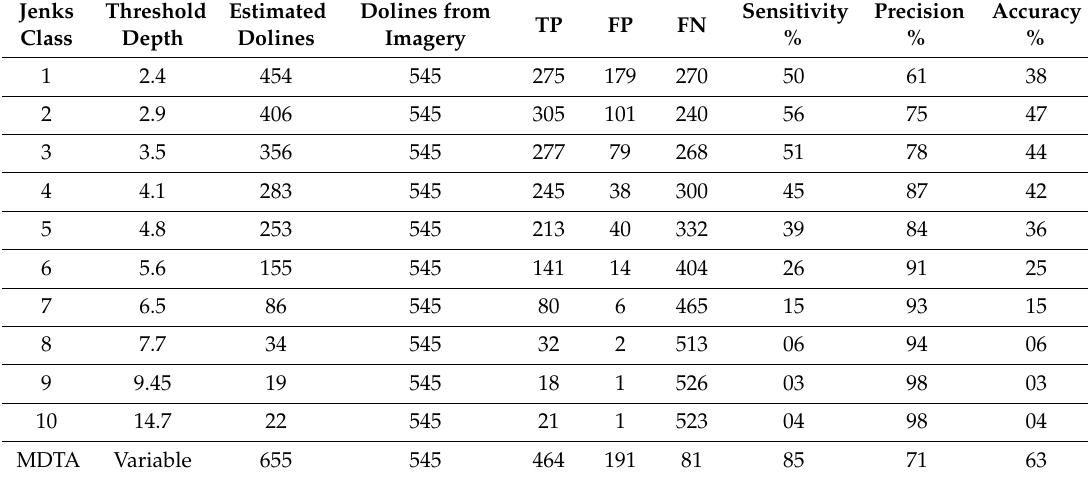
Table 1. Single thresholds derived from Jenks base 2 and results of the MDTA with DCD filter performance (scenario 3).